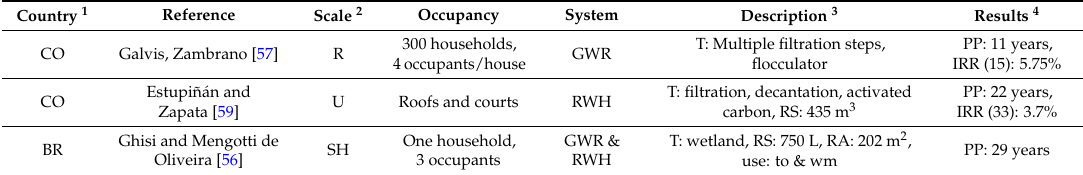
Table 7. Results of financial assessments from different